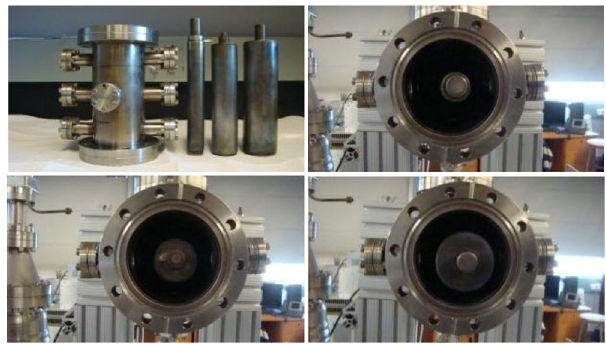
FIG. 3. Cylindrical cavity and inner electrodes with varying diameter. Clockwise: the disassembled arrangement and three end-on views of the assembled electrode configuration, starting with the lowest diameter of